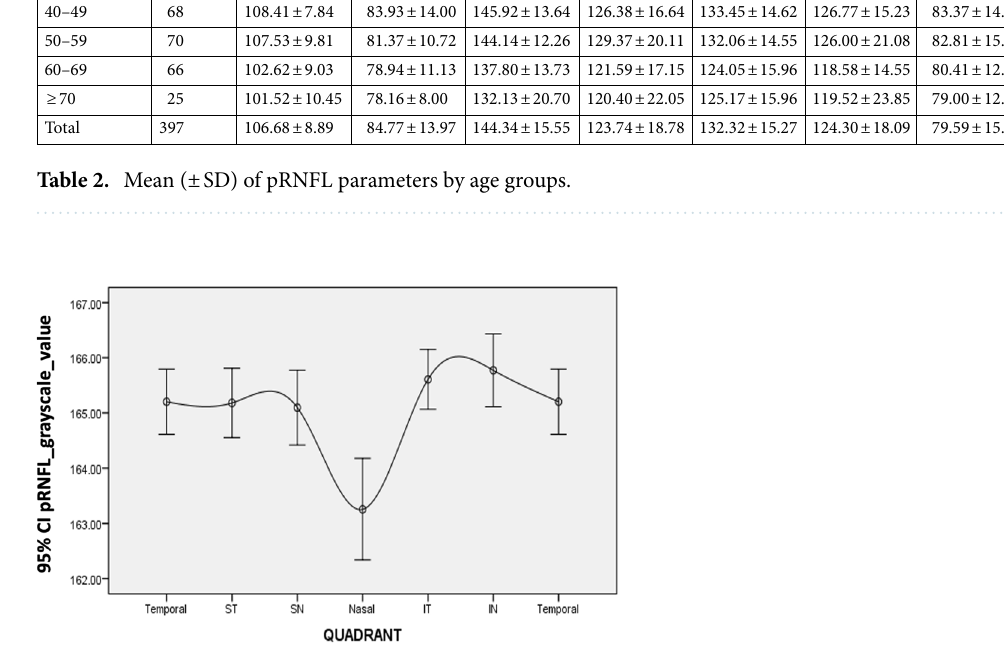
Figure 2. Sectoral distribution of pRNFL grayscale value of all study